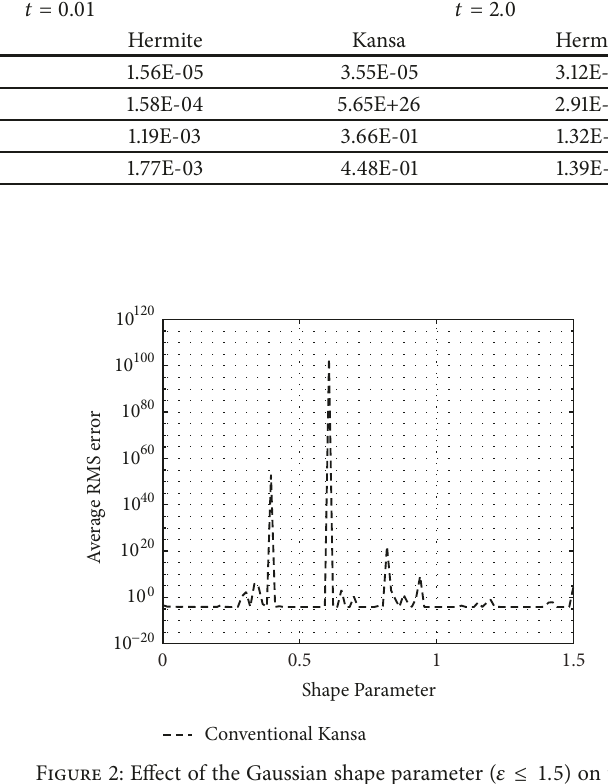
Figure 1: Effect of the Gaussian shape parameter ( 𝜀 ≤ 1.5 ) on the result accuracy for the Hermite collocation scheme computed at Re = 10 with 𝑡 = 0.5,Δ𝑡 = 0.005 , and 𝑁 = 10 × 10 .